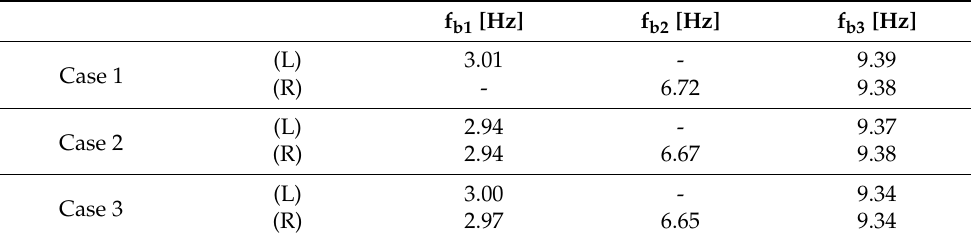
Table 1. Summary table of frequencies obtained by the direct method in the different cases of structural excitation.